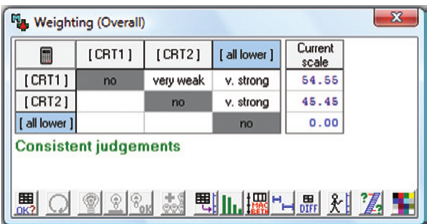
Fig. 6. Matrix of qualitative